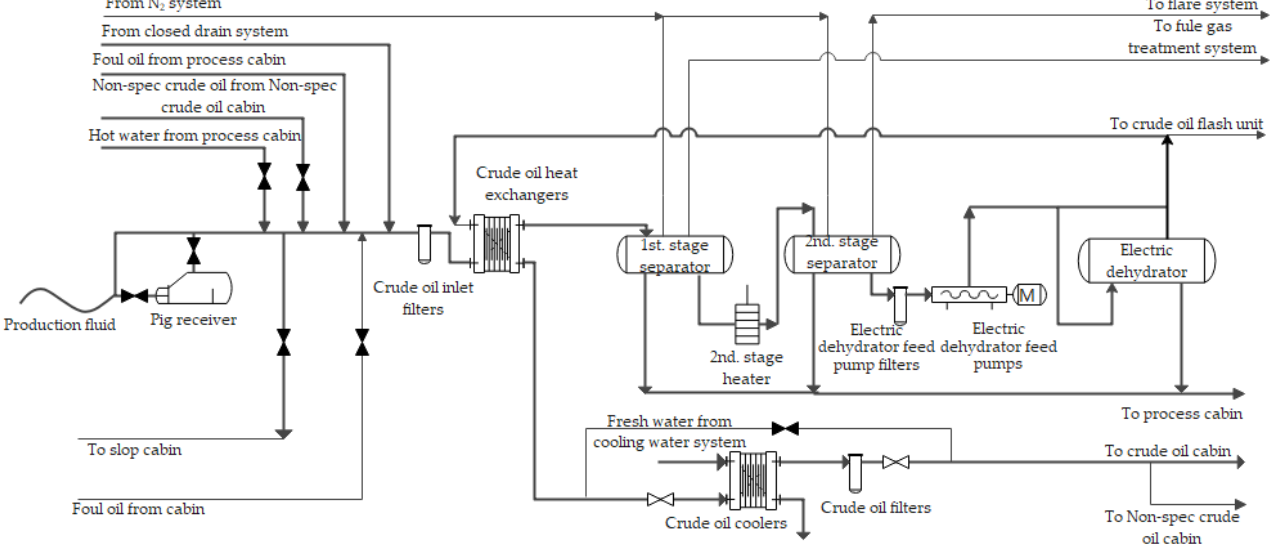
Figure 5. Process flow program of crude oil treatment system.